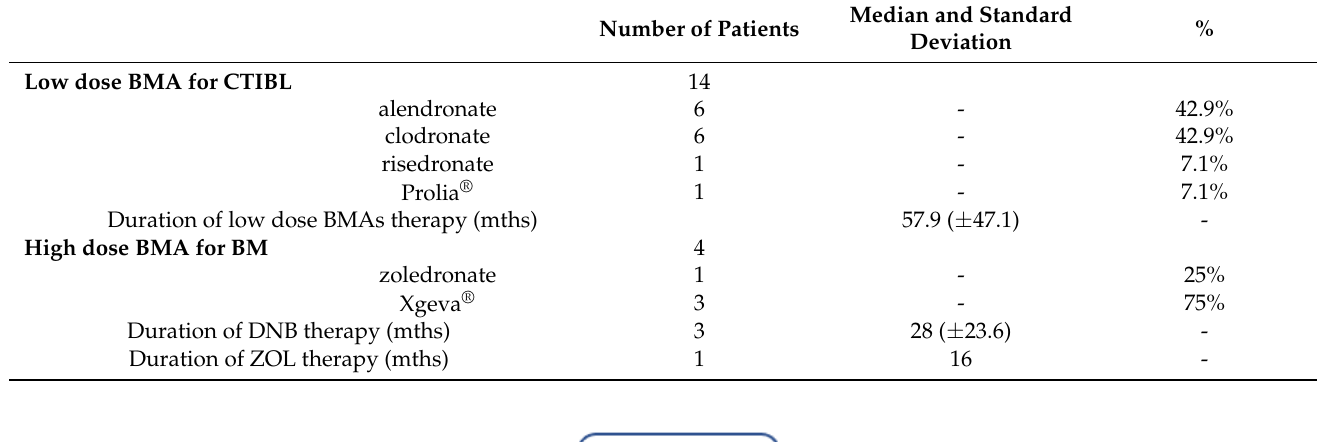
Table 2. Details of BMA therapy.